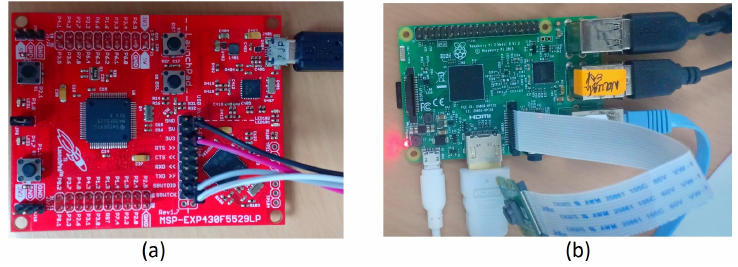
Figure 9. ( a ) MSP-EXP430F5529LP; ( b ) Raspberry